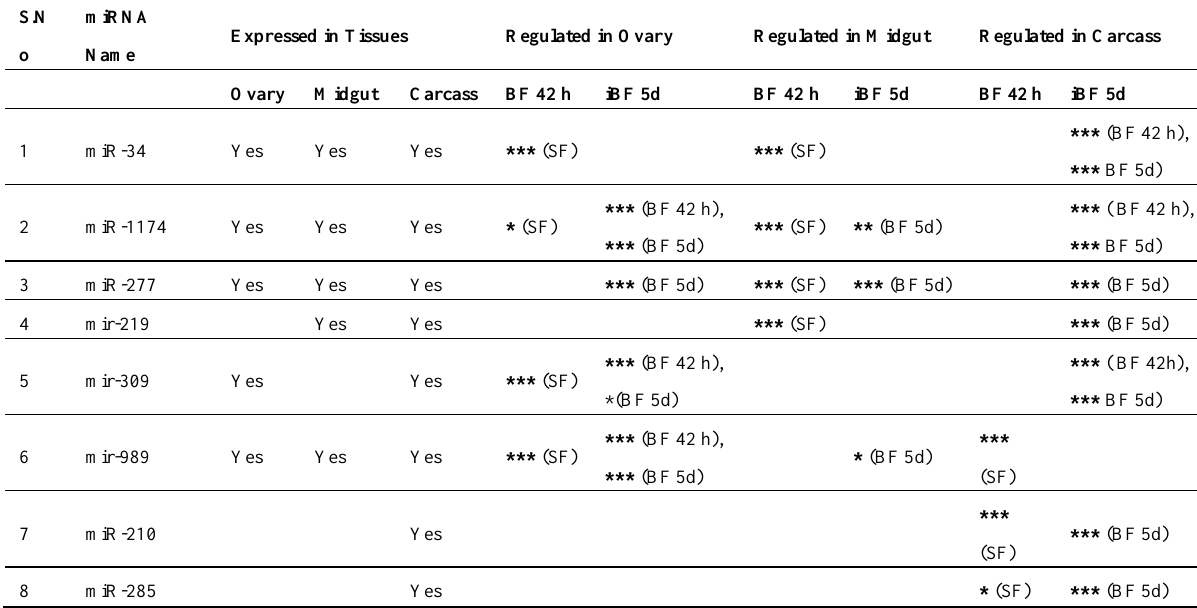
Table 1. Expression and regulation of miRNAs in different tissues of mosquitoes. Regulation of miRNAs was considered significant with * p < 0.05 ( ** p < 0.01, *** p < 0.001). Expression and regulation of miRNAs was studied in ovary, midgut and carcass tissue of sugar fed (SF), female mosquito at 42 h (BF 42 h) and 5 days (BF 5d) post blood-feeding and mosquitoes at 5 days post Plasmodium infection (iBF 5d). Sample in parenthesis indicates the experimental condition with which expression was compared to in a particular tissue of